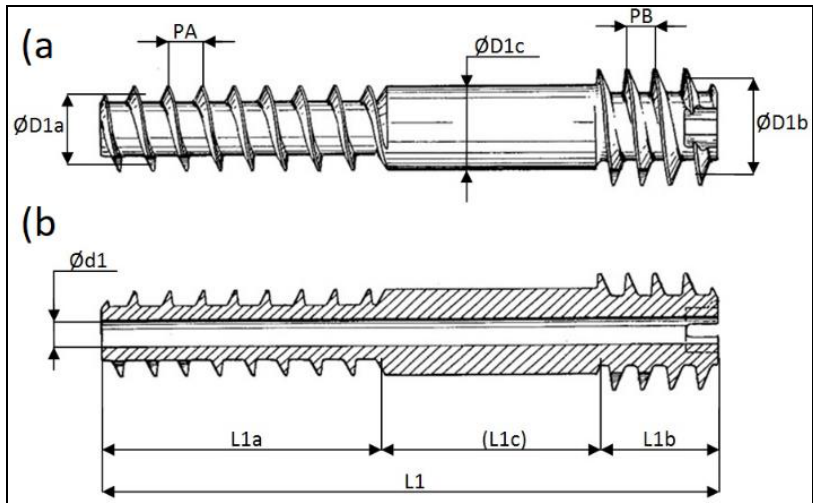
5 of 20 Figure 4. Procedure of the Herbert screw insertion.